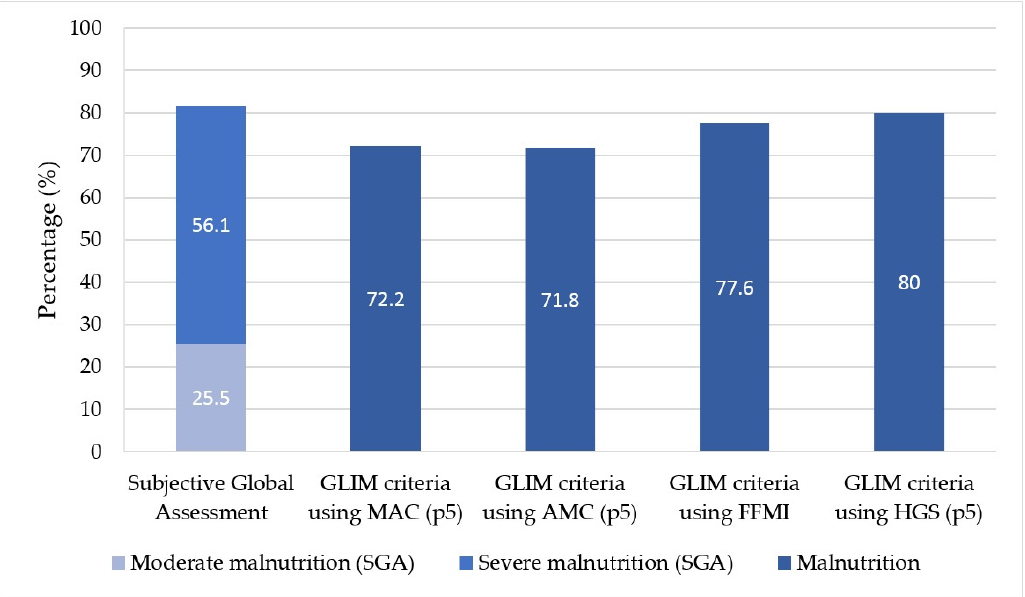
Figure 2. Malnutrition diagnosis according to the tool used. p5: fifth percentile.